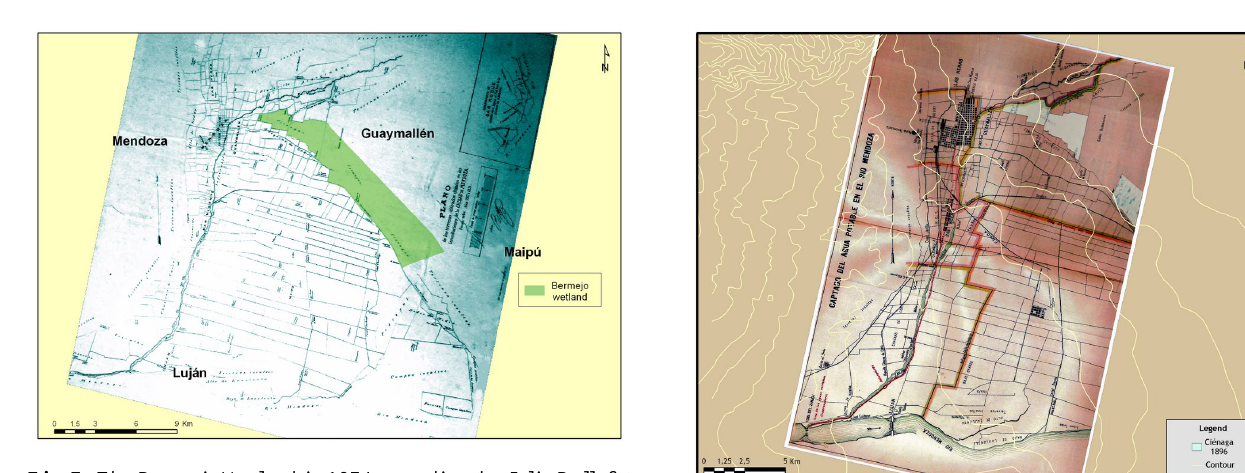
Fig. 7. The Bermejo Wetland in 1874 according the Julio Ballofet map (Mitre Museum, Buenos Aires City).